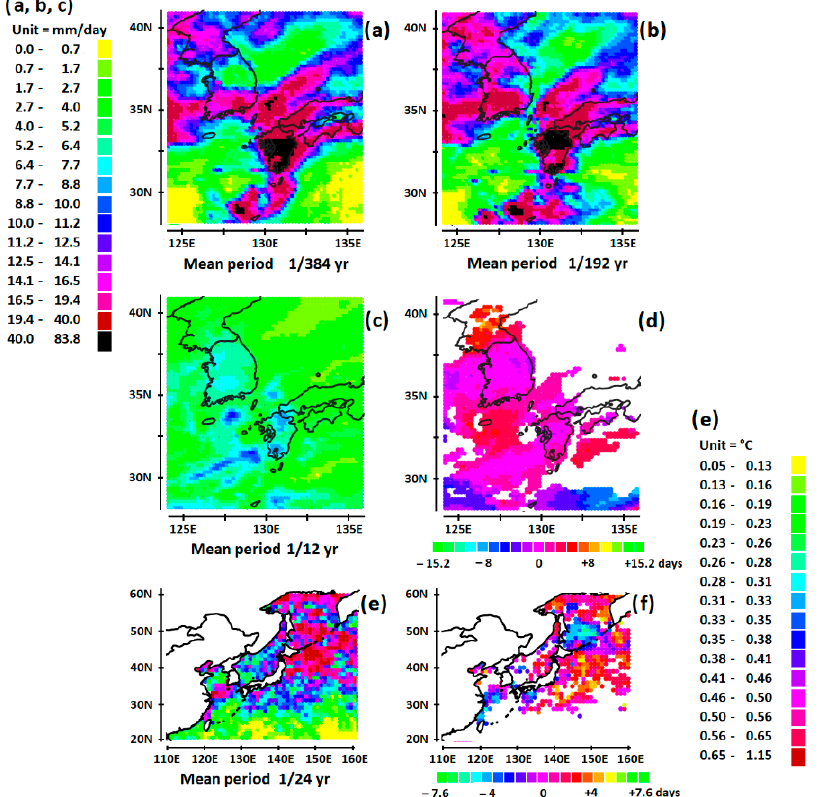
Figure 8. Extreme rainfall in Japan. Same conventions as in Figure 7. Time lags in ( d , f ) are expressed in relation to 12 July 2012. The time reference is the rainfall depth at 31 ◦ N, 131 ◦ E. Co-Evolution of SST and Rainfall Anomalies in Characteristic Period Ranges Clustering of mesoscale lows occurs in tune with the 1/12 harmonic (Figure 8c,d), involving the two branches of rainfall anomalies. On the other hand, harmonization of the thermocline depth occurs in tune with the 1/24 harmonic (Figure 8e,f). An SST anomaly greater than 0.56 ◦ C, a few days behind the ERE, is located in the Sea of Japan and in the Pacific Ocean along the Kuroshio (Figure 8e,f). Thus, the ERE occurs while the peak of the SST anomaly has not quite peaked